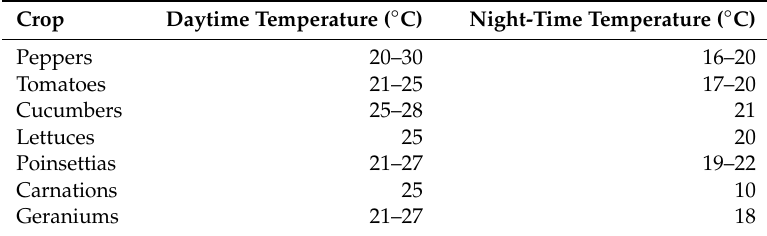
Table 5. Growing temperatures for typical greenhouse crops [69].